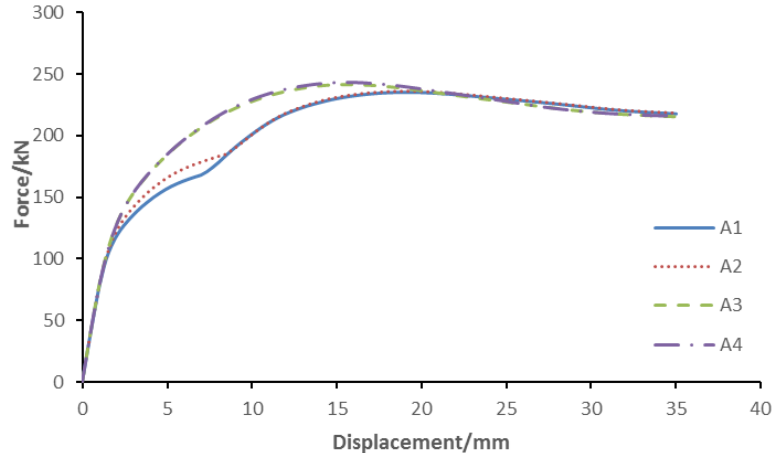
Figure 19. Slip-displacement curves.